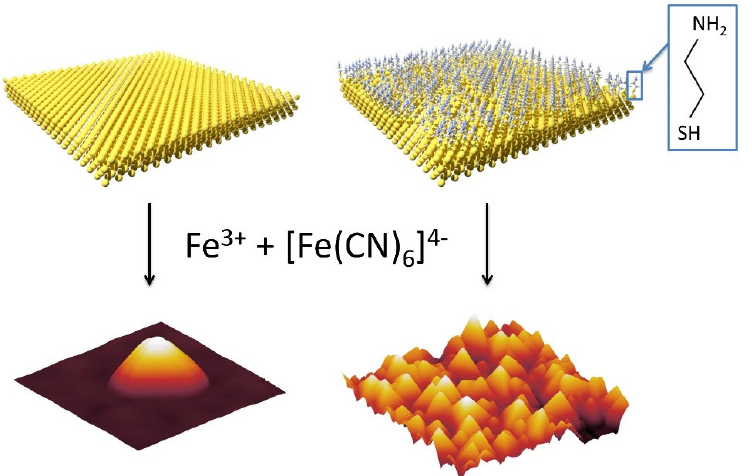
Figure 1. Schematic representation of the used approach for the growth of the PB nanostructures on the bare gold surface ( left ) and functionalized by the cysteamine gold surface ( right ).